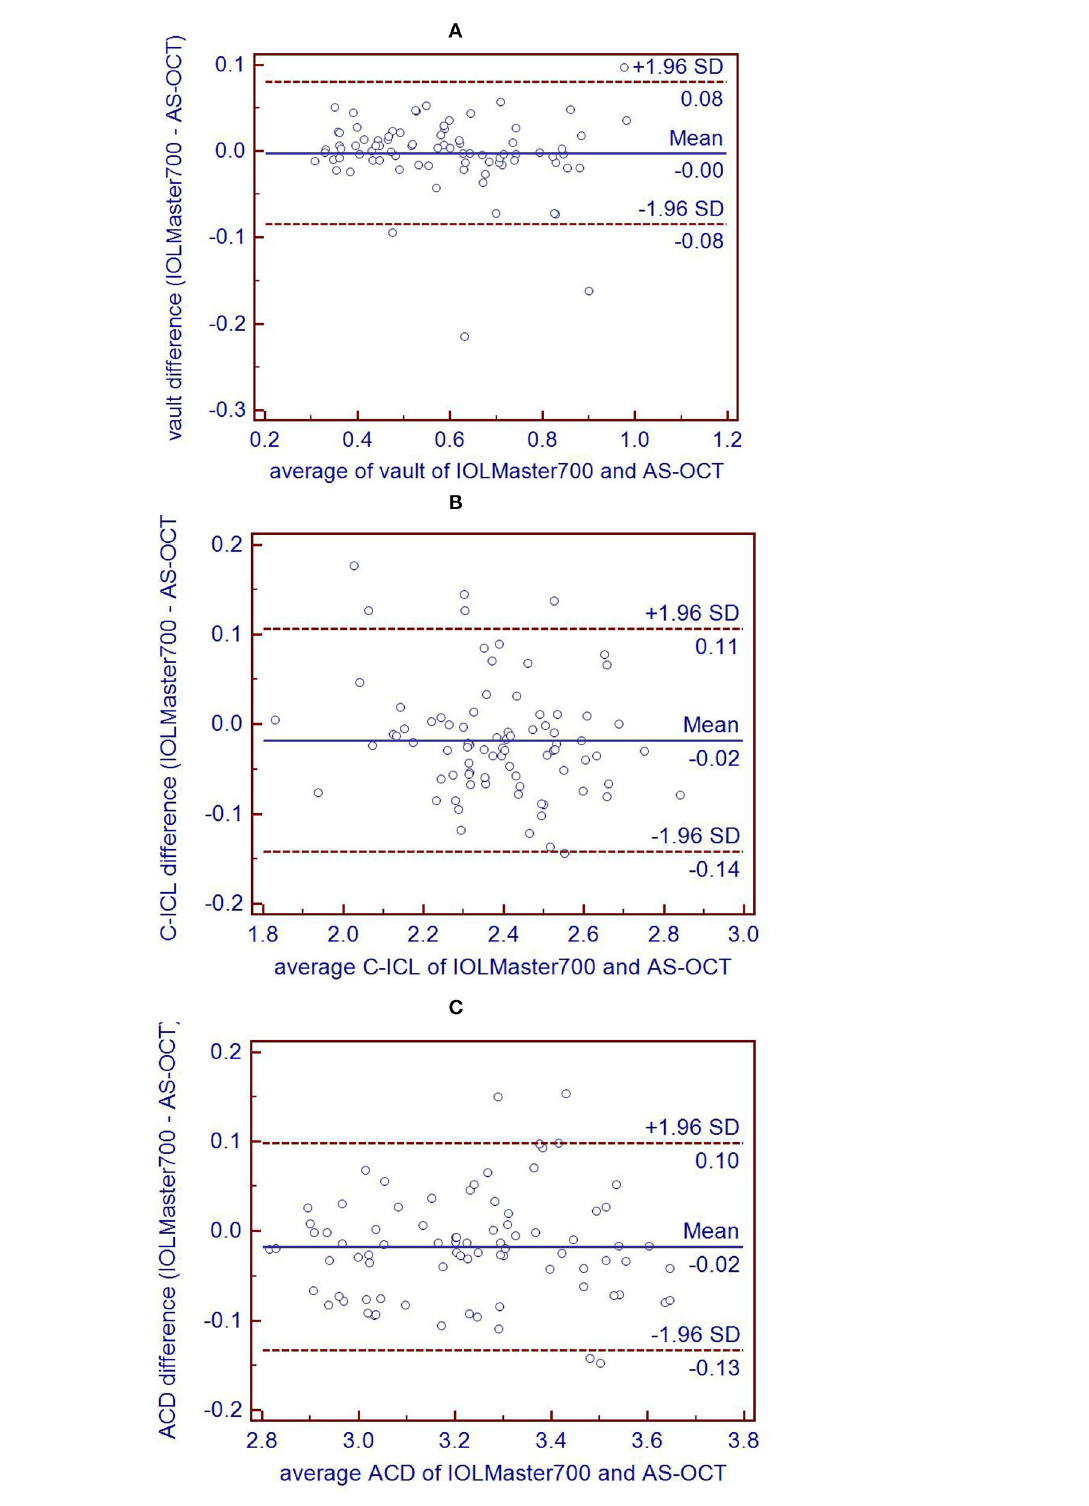
FIGURE 2 | Bland-Altman plots comparing the level of agreement between IOL Master 700 and AS-OCT measurements of vault (A) , C-ICL (B) , and ACD (C) . The vertical axis represents the difference between these measurements and the horizontal axis shows the corresponding mean value. The 95% LoA is indicated using dashed lines, and the middle bold line represents the mean difference between these